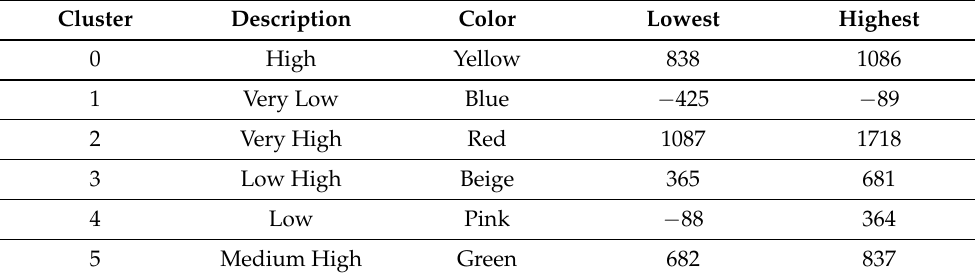
Table 5. Clusters information with K = 6.